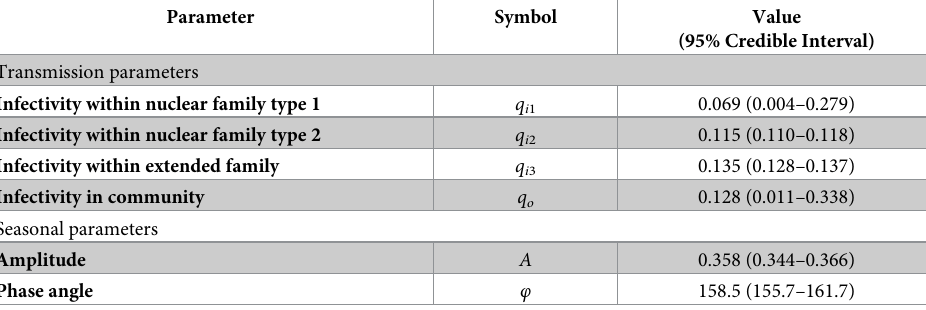
Table 1. Results of estimated parameters of RSV